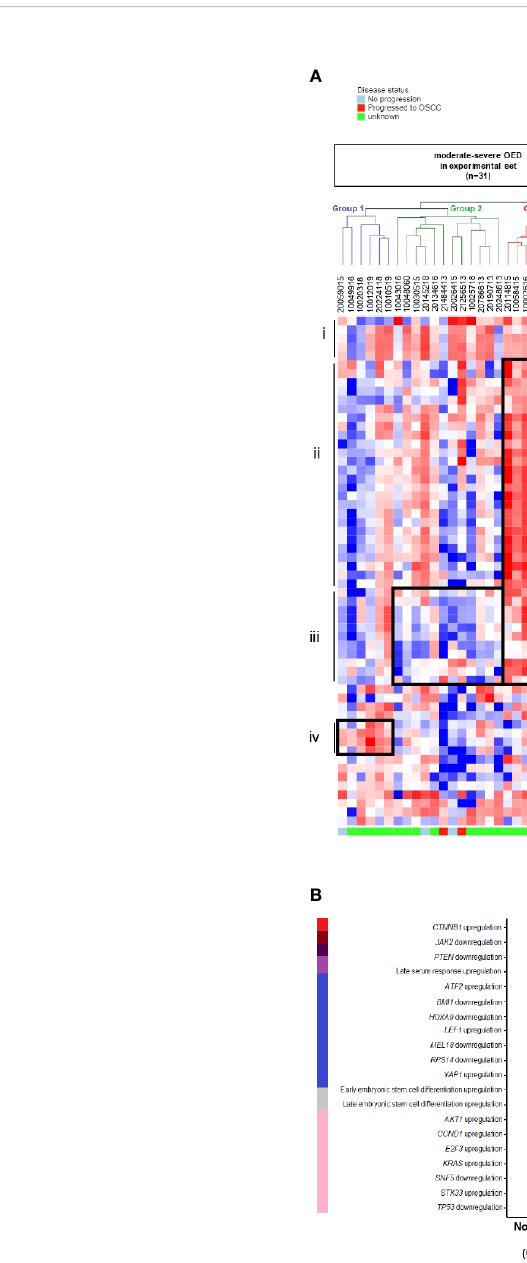
FIGURE 6 Discovery of distinct immune subtypes in moderate-severe OED and the identi fi cation of oncogenic pathways mediating immune evasion. (A) Immune signature enrichment clustered moderate-severe OED into four groups. Heatmap of unsupervised hierarchical clustering analysis of 58 immune signatures in 31 moderate-severe OED. These signatures were divided into 4 main sections: (i): Immune signatures containing NK cells and B cells. (ii): Immune signatures containing antigen presentation, T cell in fi ltration and immune checkpoints. (iii): Immune signatures related to CD8 T cell activation, interferon signaling and immune cytotoxicity (iv): Immune signatures related to oncogenic-promoting signals. Immune signatures in red are the representation of immune features described in section i to iv. Similarly, supervised hierarchical clustering of GSE26549 dataset showed that moderate and severe OED can be clustered into group 1 (non-immune reactive) and group 3 (immune cytotoxic) subtypes. (B) Enrichment plot of oncogenic signature gene sets in non-immune reactive and immune cytotoxic subtypes. The enrichment of oncogenic signature gene set was represented by the mean z-score of each subtype. Genes that promote immune evasion in cancer such as CTNNB1 , JAK2 and PTEN are detected in non-immune reactive subtype, and may be responsible for limiting T cell in fi ltration and cytotoxic response in this subtype. In addition, a relatively higher enrichment of oncogenic gene sets regulating cell cycle and proliferation was also detected in the non-immune reactive subtype when compared to the immune cytotoxic